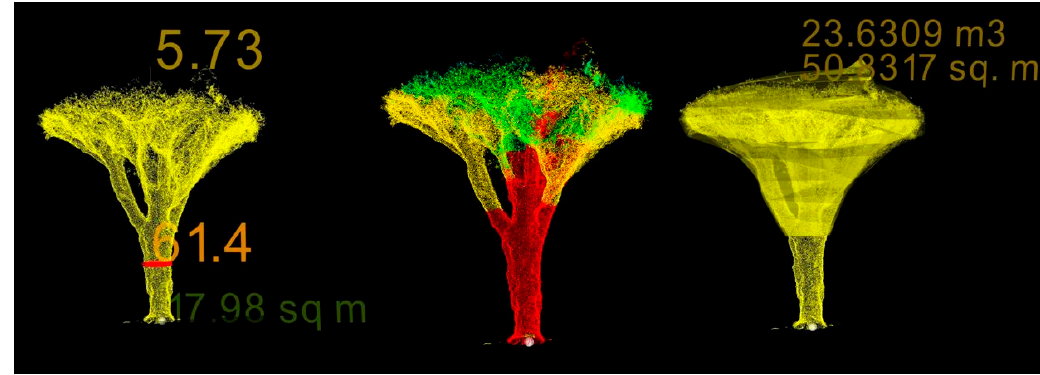
Figure 4. Tree metrics derivation in 3D Forest software. Left: D. draco example. Diameter at breast height (DBH), height, and convex planar projection; middle: segmentation of tree in the process of volume calculation; right: canopy volume and surface calculation.